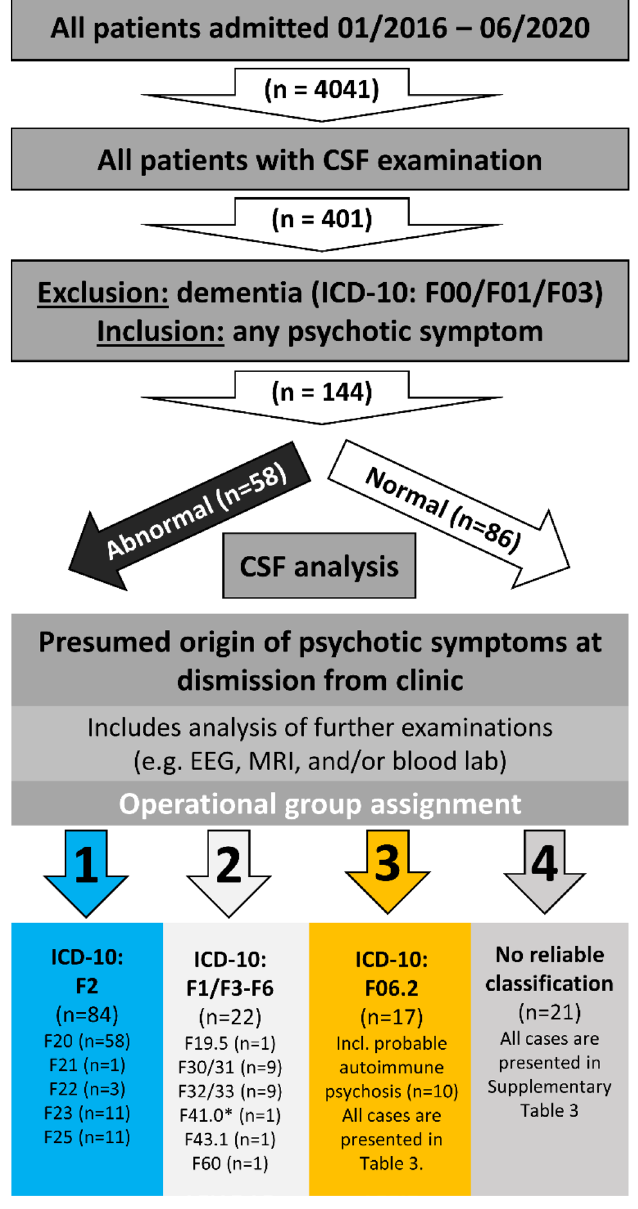
Figure 1. Study diagram. The study diagram shows the workflow of this retrospective analysis of n = 4041 psychiatric inpatient cases. After exclusion of cases with discharge diagnosis of dementia n = 144 cases with any psychotic symptoms and available CSF analysis were identified. These cases were dichotomized into abnormal vs. normal CSF results (for details, see Fig. 2), based on available CSF results. All cases were analyzed in detail and then operationally assigned to one of four groups, taking further examination results into account. All F2 cases constitute the first group (n = 84). The second group consists of other psychiatric disorders with psychotic symptoms (F1/F3-F6) with the exact ICD-10 diagnosis named below. (*) The F41.0 case presented with an additional Attenuated Psychosis Syndrome (as described in DSM5) with hallucinations. The F06.2 group includes the predefined probable autoimmune psychosis (criteria according to Pollak 10 , n = 10) and seven additional cases. In 21 cases, the abnormal findings (CSF and furthers) were not sufficient to explain the psychotic symptoms; they were categorized as "no reliable classification" due to lack of clear predefined